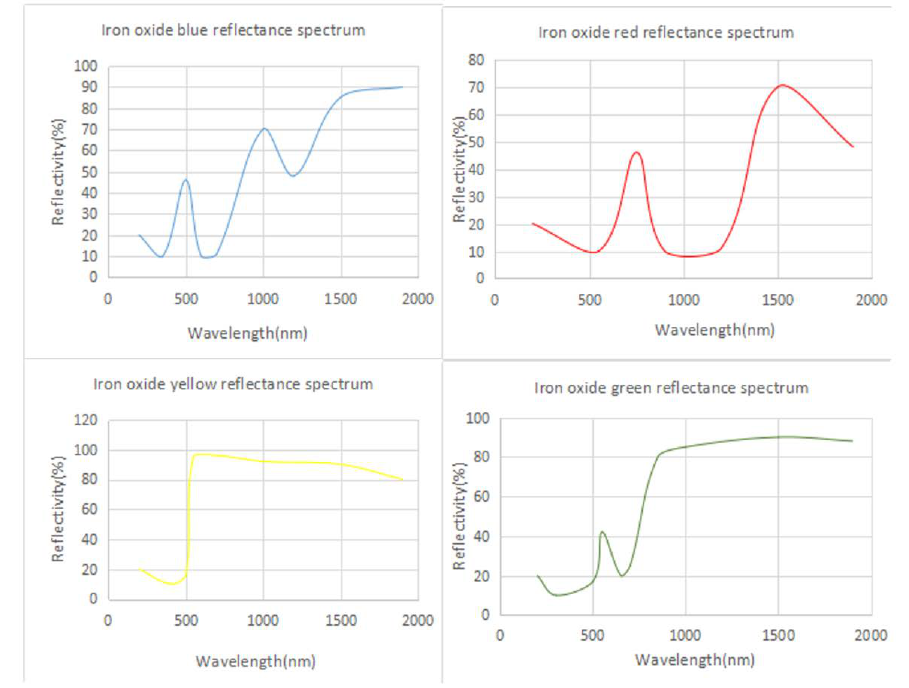
Figure 5. Full spectrum reflectance of di ff erent filler powders (200–2500 nm).